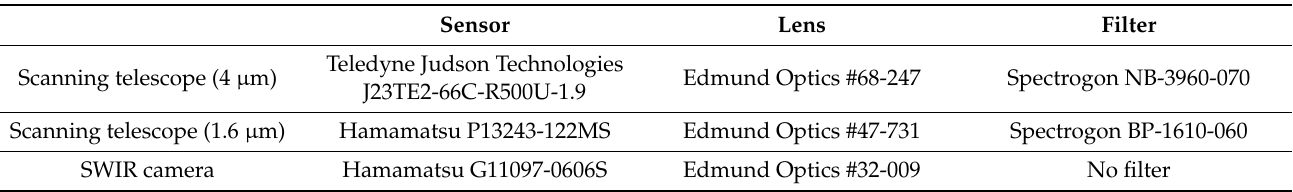
Table 1. Components of the scanning telescope and SWIR camera.